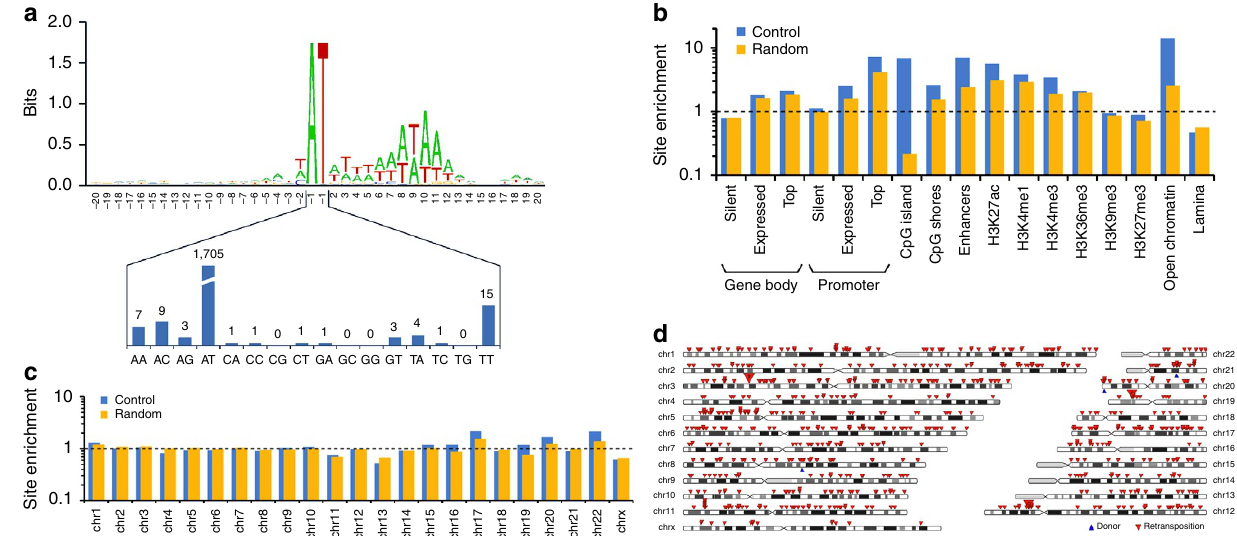
Figure 5 | Genome-wide analysis of de novo Helraiser insertions in the human genome. ( a ) The sequence logo was created with WebLogo (http://weblogo.berkeley.edu). Transposon integrations are between the positions (cid:2) 1 and 1. The lower panel shows the distribution of dinucleotides at the integration sites. ( b ) Fold enrichment of relative integration frequencies compared with random genomic sites (yellow) and control sites imitating the base composition characteristics of Helraiser integration sites (blue). Top genes are the 500 genes with highest expression level. Integration frequencies into promoter regions of silent genes and H3K9me3 regions were not significantly different from controls; all other differences were statistically significant (Fisher’s exact test P value r 0.05). ( c ) Fold enrichment of relative integration frequencies per chromosome compared with random genomic sites (yellow) and control sites imitating the base composition characteristics of Helraiser integration sites (blue). ( d ) Chromosomal distribution of 701 Helraiser retransposition events (red arrows). Blue arrows represent the positions of the original chromosomal donor